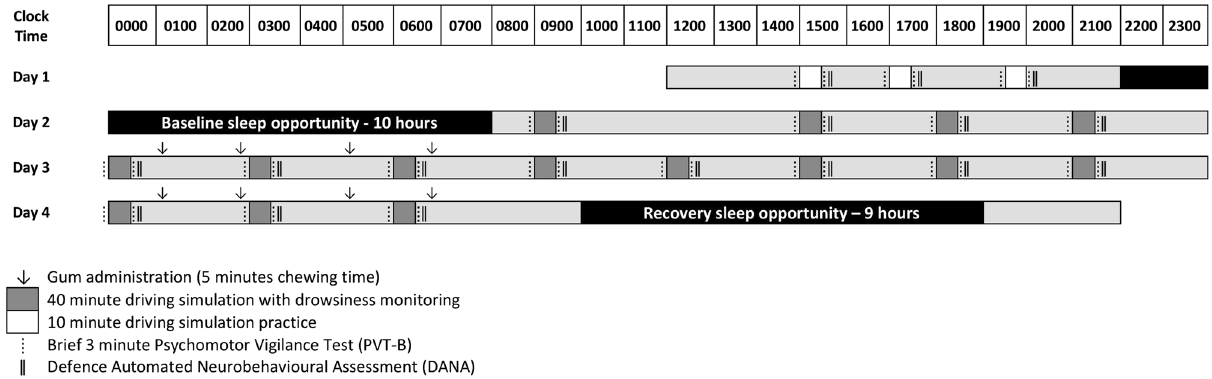
Figure 6. Protocol schematic indicating caffeine administration, simulated driving sessions, cognitive testing sessions and sleep The resulting sample’s age ranged from 18 to 28 years (M = 22.46 ± 2.73) and BMI ranged from 20.70 to 24.73 kg/ m 2 (M = 21.89 ± 1.37). Procedure. Participants were randomly allocated into either placebo or caffeine group. There were no sig- nificant differences in age or BMI between the two groups and gender was evenly distributed between condi- tions. Participants’ sleep was monitored using sleep diaries and actigraphy for a week prior to the study. They were given a 10-h sleep opportunity. Participants were also required to abstain from caffeine and alcohol, as one week of caffeine abstinence is known to sharpen the effects of its re-introduction and to have minimal with- drawal effects. The experiment took place in the sleep laboratory at the Centre for Sleep Research at the University of South Australia. Ambient temperature was 22 ± 1 °C, light levels were ≤ 50 lx during wakefulness and ≤ 1 lx during sleep. Day 1 of the protocol was dedicated to habituation, training, and oculography equipment calibration. After a 10-h sleep opportunity (2200–0800), data collection commenced at 0800 on Day 2. Participants were constantly monitored and remained awake for 50 h. Every three hours (see Fig. 6) participants drove for 40 min continuously in a medium-fidelity driving simulator (average motion 0.08 m/s 2 calculated as the root mean square addition of the three motion axes) and controlled by Virtual BattleSpace 2 (VBS-2, Bohemia, USA) to represent a slightly curved two-lane rural highway at dusk. During the driving task, a randomly selected subgroup of eleven par- ticipants (five from the caffeine group and six from placebo group) wore an infra-red oculography monitor that quantified drowsiness levels in the form of the Johns Drowsiness Scale (JDS) scores 20,21 . The JDS scores aggregate oculography parametres over 60-s epochs and range from 0 (very alert) to 10 (very drowsy) with a JDS score between 0 and 4.4 indicating relatively low risk, 4.5–4.9—moderate and scores above 5.0 indicate critical levels of drowsiness 22 . Five consecutive JDS scores immediately preceding the cognitive test- ing, formed the JDS predictor of cognitive performance. Directly before and after each driving task, participants completed a 3-min Psychomotor Vigilance Test (PVT- B) and self-reported sleepiness score. Participants also completed a cognitive testing battery using the Defense Automated Neurobehavioral Assessment (DANA) following the post-drive PVT-B. The caffeine group was administered four doses of caffeine via gum pellets [200 mg/2 pellets per dose, Mili- tary Energy Gum (MarketRight INC, Plano, IL, USA)] every two hours (0100, 0300, 0500, 0700) on the first and second nights of sleep deprivation. The placebo group was administered four doses of non-caffeinated chewing gum that was identical in appearance and flavour, at the same time points. All participants were instructed to chew both pellets for a minimum of 5 min, as prior research shows that 85% of the dose is released within 5 min of chewing 19 . The resulting daily dose of 680 mg (85% of 800 mg) is higher than population-wide consumption averages but comparable with typical consumption levels in shift-worker populations 31 . It is also consistent with recent review findings of no adverse neuro-behavioural effects of up to 600 mg/day caffeine consumption 32 . A double-blind randomisation protocol was maintained throughout: all gum labelling was removed and neither the participants nor the researchers knew which group they belonged to. Infra‑red oculography: the johns drowsiness scale. Driver drowsiness levels were monitored continuously throughout the simulated drives using the Optalert Alertness Monitoring System (OAMS; OptAlert, Melbourne, VIC, Australia). The OAMS uses spectacle frame-mounted infra-red sensor to continuously monitor eye and eyelid movements during blinks—including their timing, duration, and velocity. These ocular parameters are then combined to quantify drowsiness levels in the form of the Johns Drowsiness Scale (JDS) scores 20 . The OAMS estimates drowsiness by generating a JDS score over regular epochs. Epoch duration was set at 60 s, producing 40 data points for each drive period. For the current analysis we utilised the last five of these 40 data points, covering the 5-min period immediately prior to the cognitive testing. The JDS scores range from 0 (very alert) to 10 (very drowsy) with a JDS score between 0 and 4.4 (inclusive) indicating a relatively low risk level of